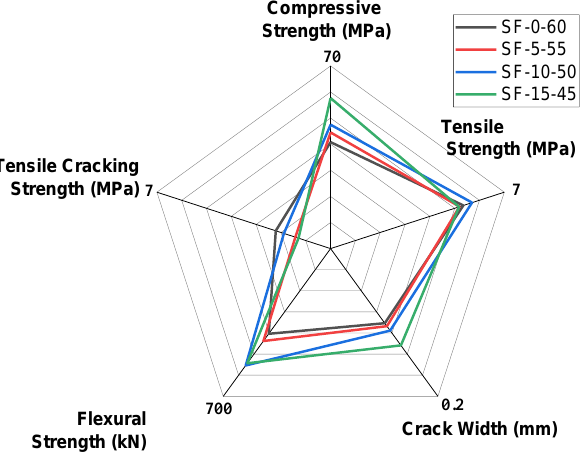
Figure 10. Multi-parameter assessment of mechanical and cracking characteristics of slag/fly-ash- based ECCs (SF-0-60, SF-5-55, SF-10-50, and SF-15-45).